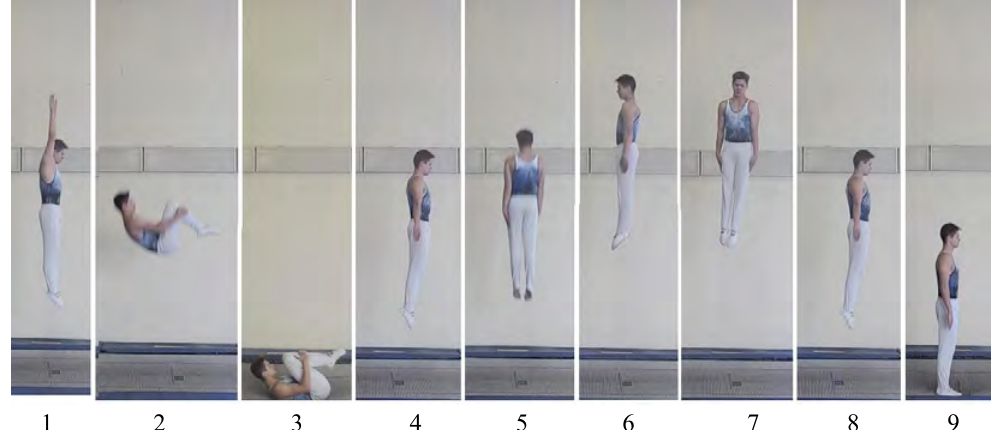
Fig 16. Combination 4. Temp jump (shot 1); jump backward, taking position landing on back and grouping (shots 2 – 3); jump forward and temp jump with turn by 360° (shots 4 – 8); stop (shot 9). 2 repetitions in every attempt, (2-3